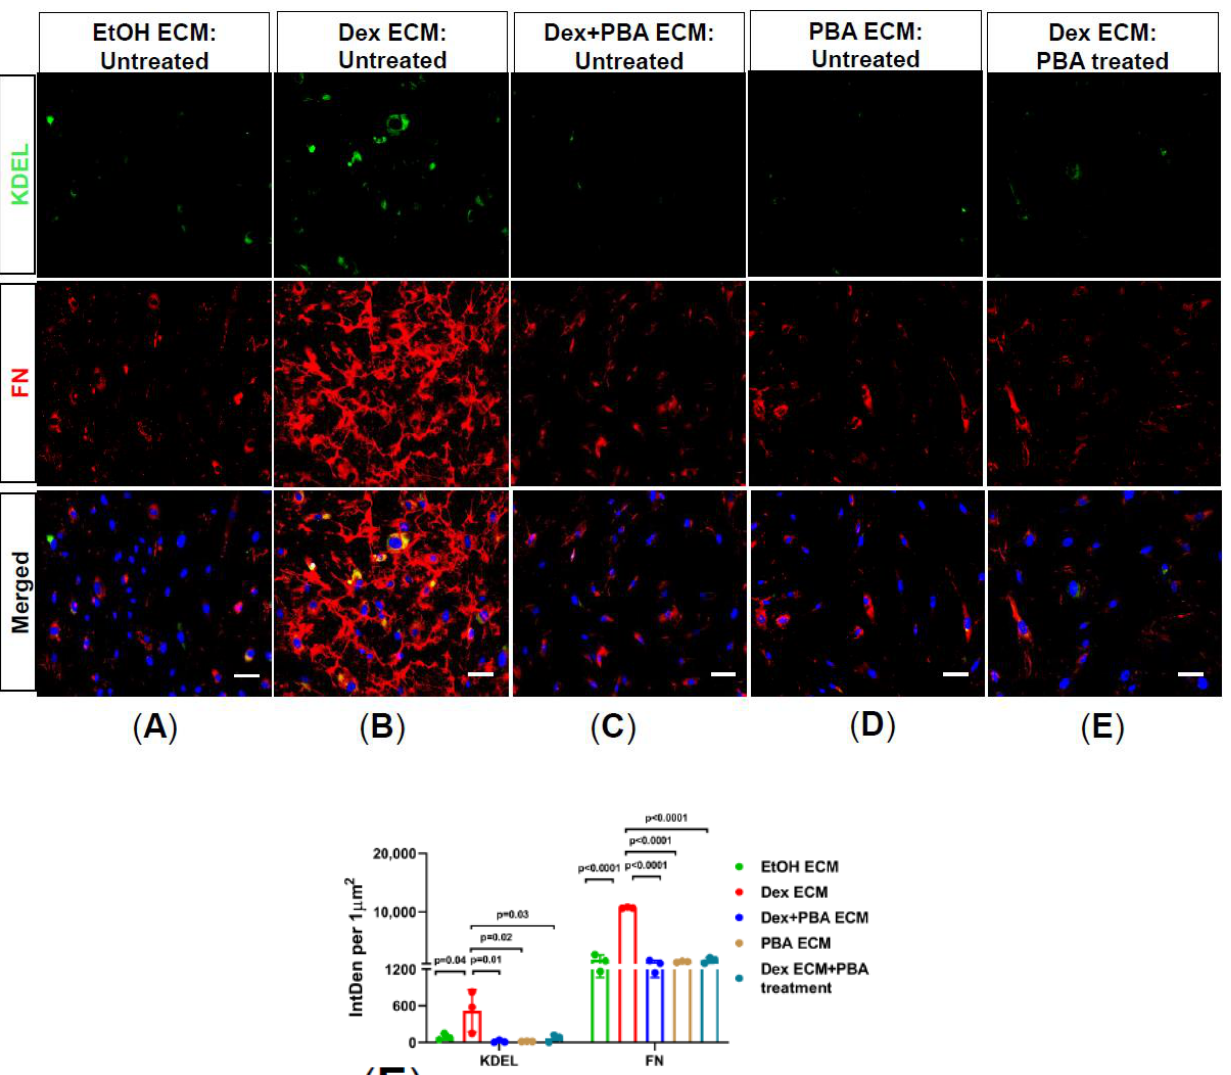
Figure 4. PBA degrades ECM deposition and prevents ER stress in primary human TM cells: Primary human TM cells were grown to 80% confluency on the chamber slides, and then treated with either ethanol (control) or Dex (100 nM) or Dex plus PBA (5 mM) or PBA for 7 d and subjected to decellularization. Following complete decellularization, fresh primary human TM cells were re-grown on decellularized ECM for another 5 d, left either untreated ( A – D ) or treated with PBA (5 mM) ( E ). Representative immunostaining images ( A – E ) and their intensity measurements ( F ) confirmed that abnormal ECM derived from Dex-treated TM cells ( B ) induces ER stress (KDEL) compared to TM cells grown in control-derived ECM ( A ). Primary TM cells re-grown on Dex + PBA ( C ) and PBA ( D ) derived ECM did not trigger ER stress compared to Dex-induced ECM deposition ( B ). Interestingly, freshly regrown TM cells on Dex-derived ECM showed no signs of ER stress (KDEL) and degradation of ECM (FN) upon PBA treatment ( E ). ( n = 3 strains, scale bar 50µm, ONE WAY ANOVA with multiple comparison).